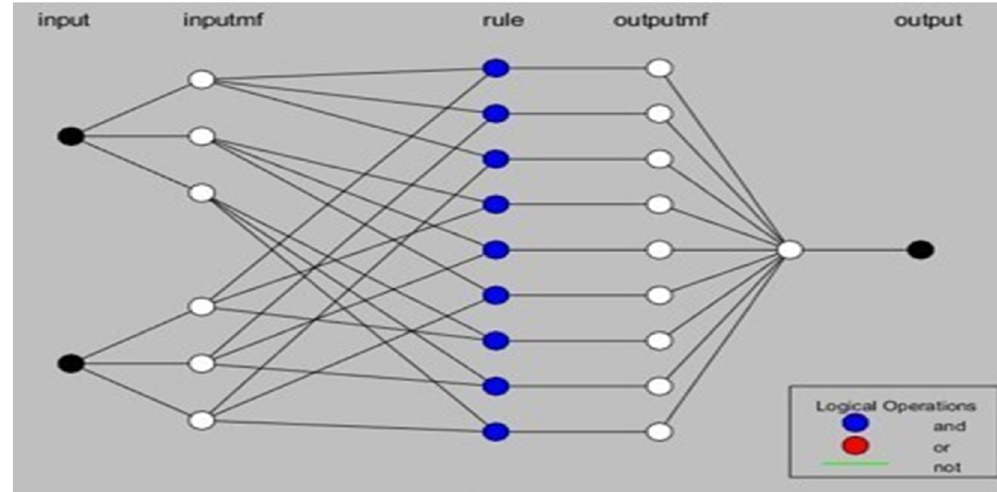
Figure 4: ANFIS with input and output layers for the calculation of Q c